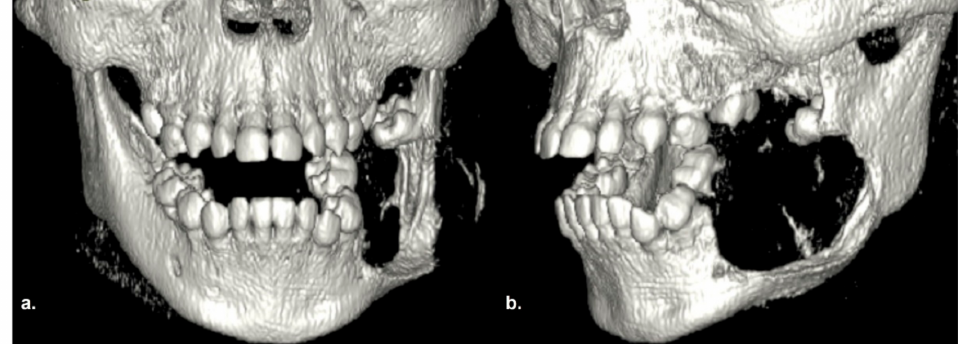
Figure 3. Three-dimensional facial computed tomography (CT) reconstructions. The bone defect of the left hemimandible is evident. ( a ) Frontal view; ( b ) three-quarter left-sided view.